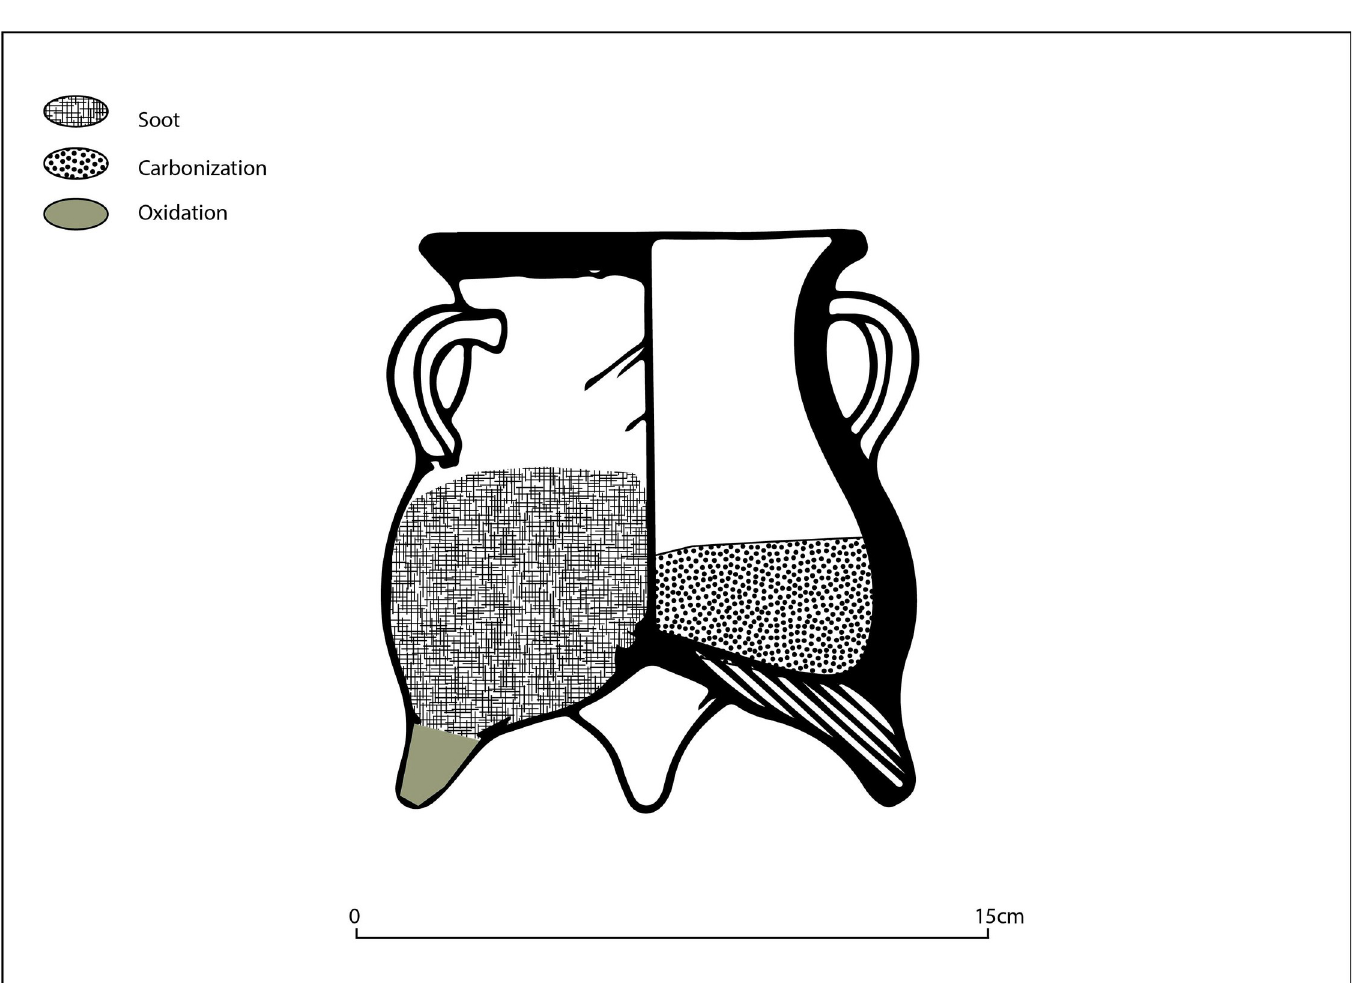
Fig 6. Schematic image of dominant use-wear pattern observed on Siwa li cooking